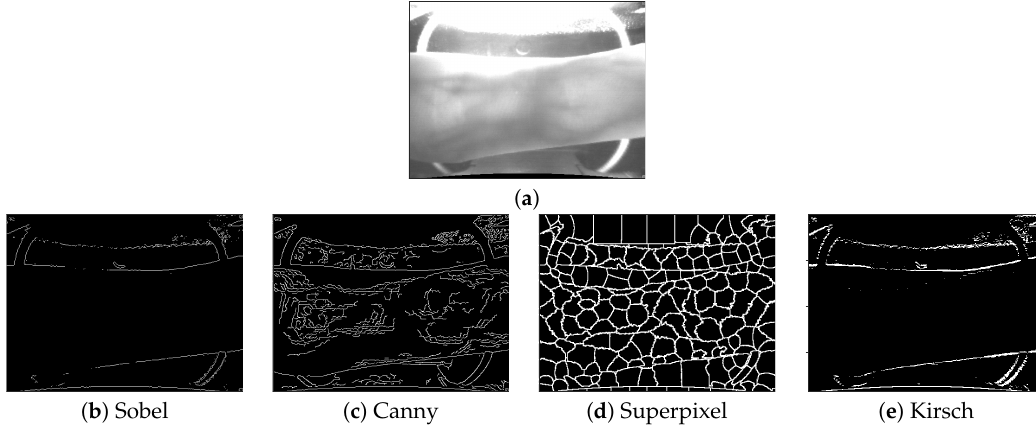
Figure 3. Edge results by using different edge detection operators for an example: ( a ) original finger-vein image, ( b ) Sobel, ( c ) Canny, ( d ) superpixel [38], and ( e )